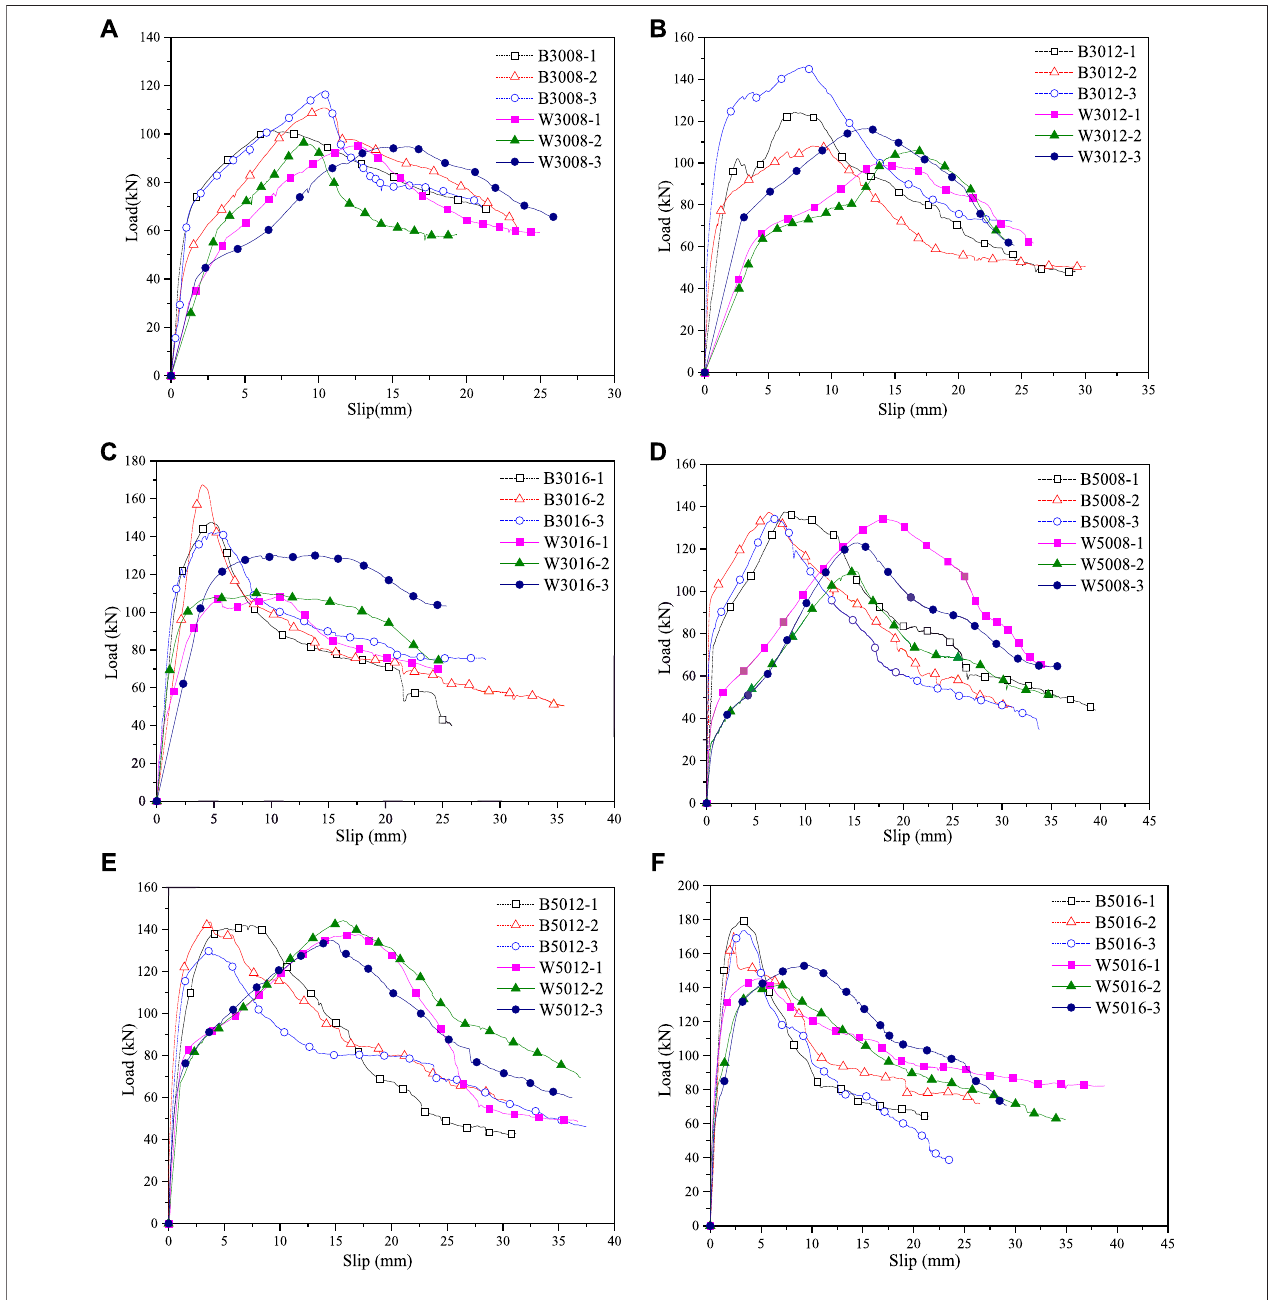
FIGURE 9 | Comparison of load-slip curves of bamboo-concrete and wood-concrete connections. (A) 3008, (B) 3012, (C) 3016, (D) 5008, (E) 5012, and (F) 5016.